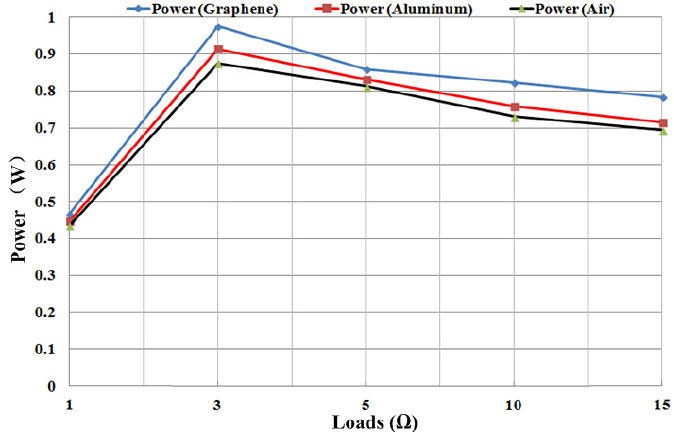
Figure 16. The output power of TE board with different thermally conductive materials in different loads.